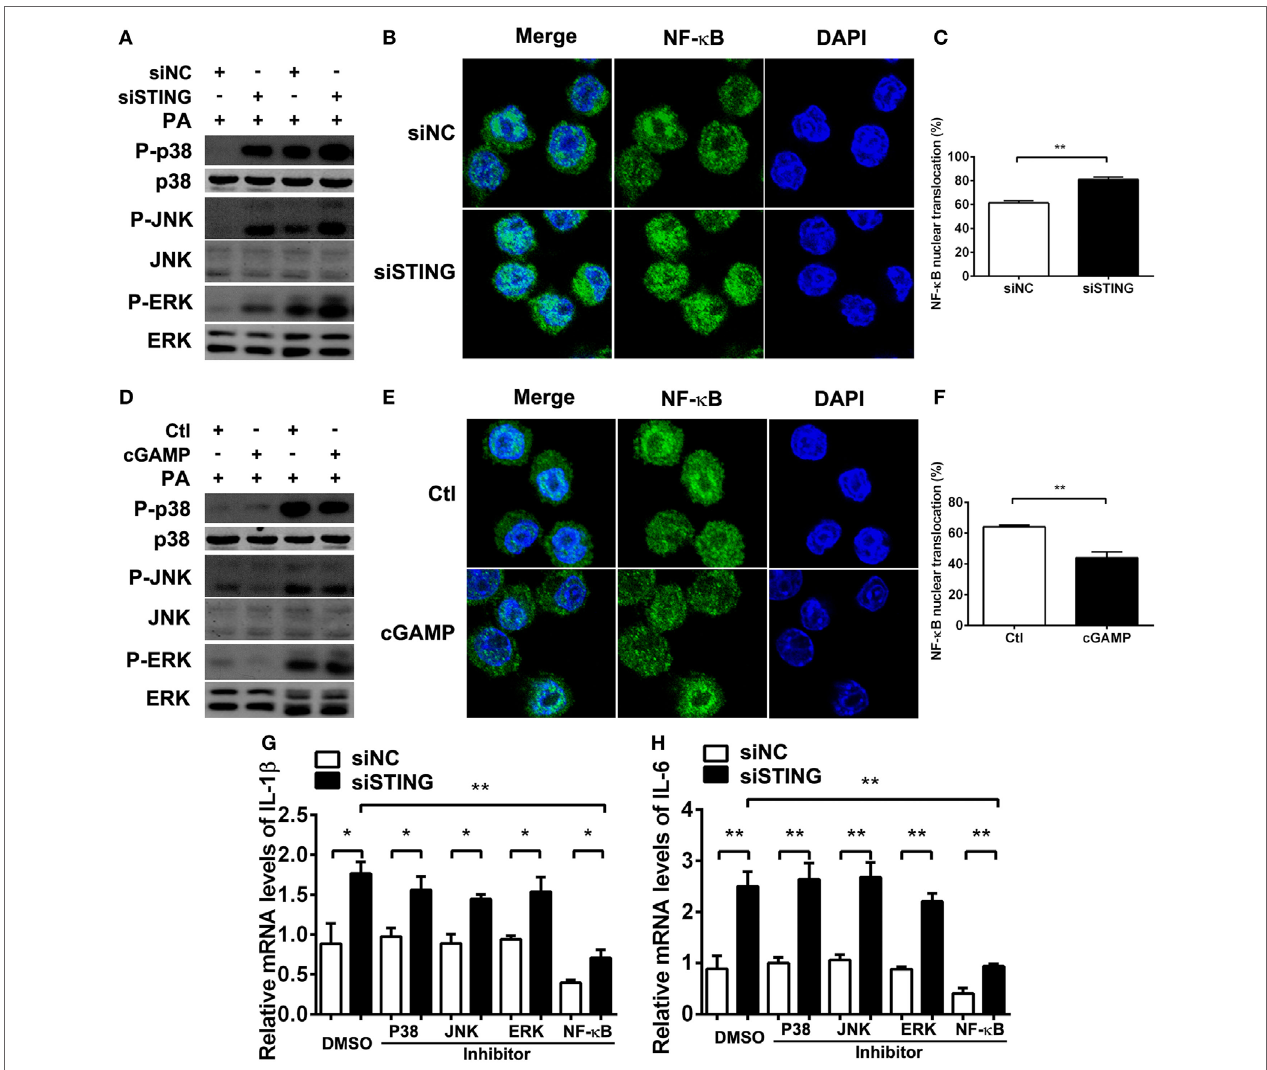
FigUre 8 | Stimulator of interferon genes (STING) suppressed inflammatory cytokine expression via restraining nuclear factor- κ B (NF- κ B) activity. (a,D) The protein levels of phosphorylated p38 (P-p38), p38, phosphorylated c-Jun N-terminal kinase (P-JNK), c-Jun N-terminal kinase (JNK), phosphorylated extracellular regulated protein kinases (P-ERK), and ERK were measured by Western blot at 30 min and 1 h postinfection (p.i.) in RAW264.7 cells after being treated with siRNA for mouse STING (siSTING) versus siNC (a) and 2 ′ ,3 ′ -cGAMP (cGAMP) versus control (D) . (B,e) The nuclear translocation of NF- κ B (the colocalization of NF- κ B and nuclear staining with 4,6-diamino-2-phenyl indole) was measured by immunofluorescence at 6 h p.i. in RAW264.7 cells after being treated with siSTING versus siNC (B) and cGAMP versus control (e) , and (c,F) the percentage of cells with NF- κ B nuclear translocation was quantified by counting more than 200 cells in three random fields. (g,h) mRNA levels of interleukin 1 beta (IL-1 β ) (g) and interleukin 6 (IL-6) (h) were measured by real-time PCR at 6 h p.i. in RAW264.7 cells after treatment with siSTING versus siNC, followed by treatment with P38 inhibitor, JNK inhibitor, ERK inhibitor, NF- κ B inhibitor versus DMSO vehicle control. Data are shown as mean ± SEM of three independent experiments. * P < 0.05; ** P <